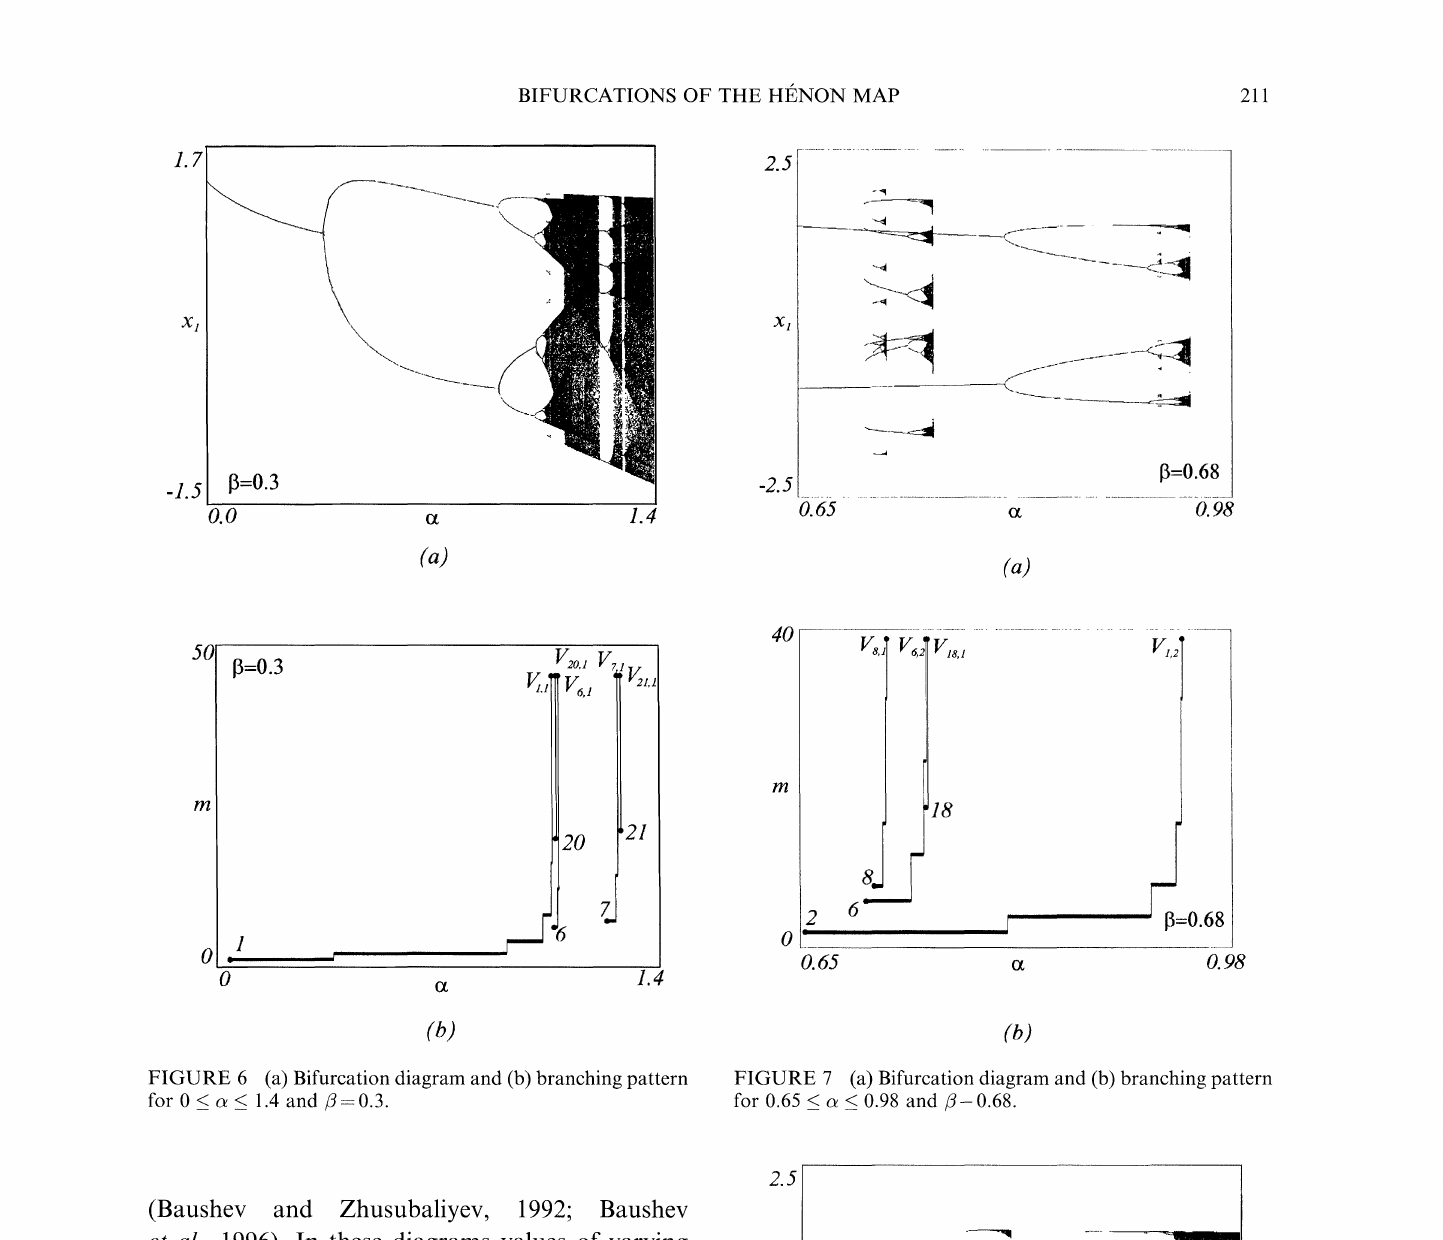
FIGURE 7 (a) Bifurcation diagram and (b) branching pattern for 0.65 _< c < 0.98 and/3-0.68.